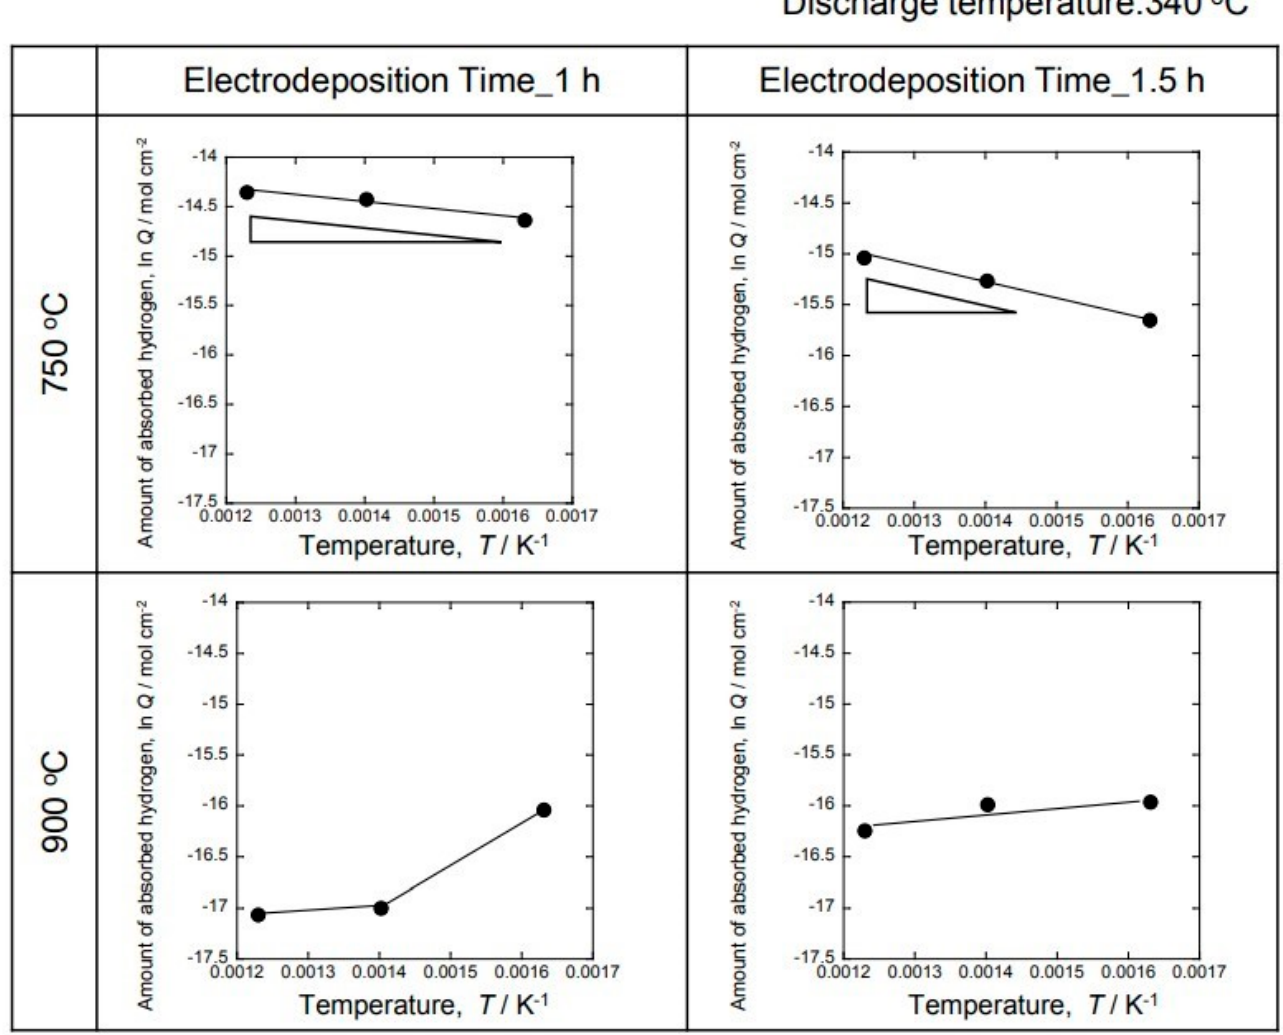
Figure 10. Arrhenius plots of Ni after La deposition at − 2.25 V in NaCl-KCl-5.0 mol%LaF 3 melts at 750 °C and 900 °C.